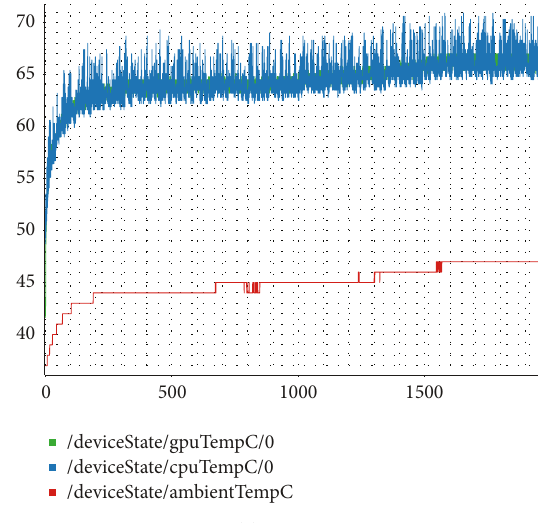
Figure 11: T1D2 temperatures.